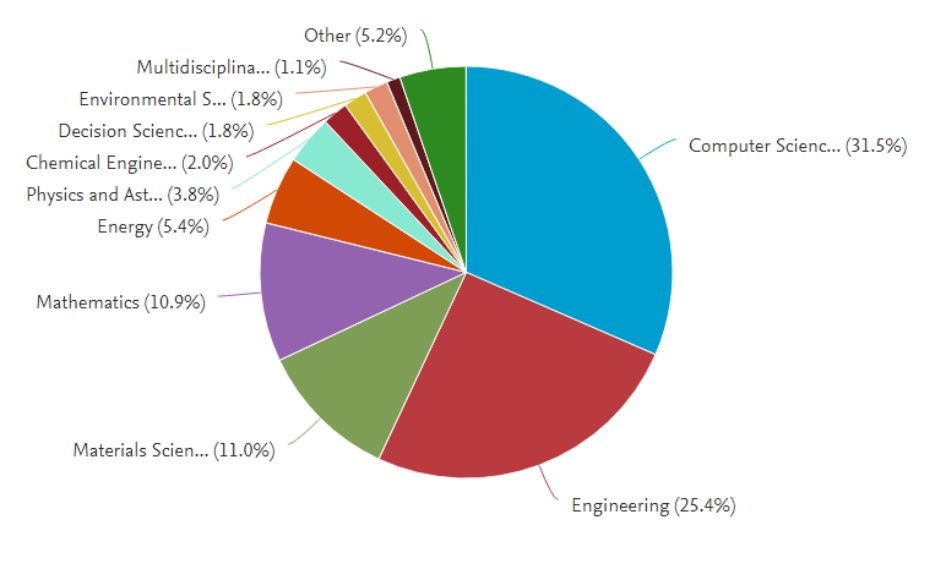
Figure 12. Distribution of HHO-related papers in many applications, as reported by